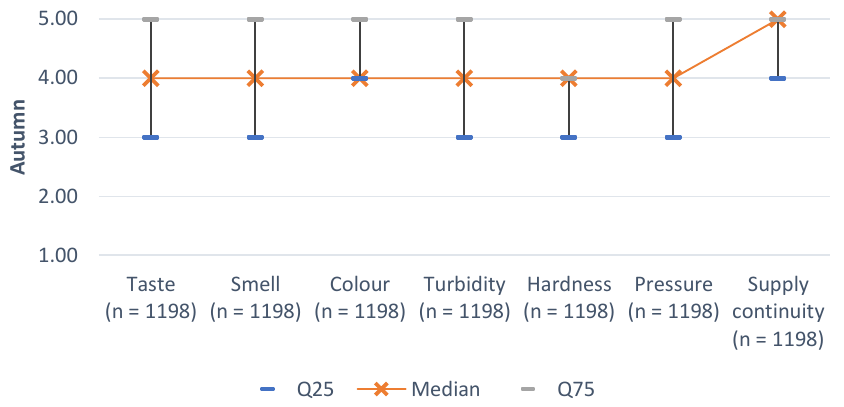
Figure 4. Respondents’ evaluation of individual tap water parameters during the autumn period.